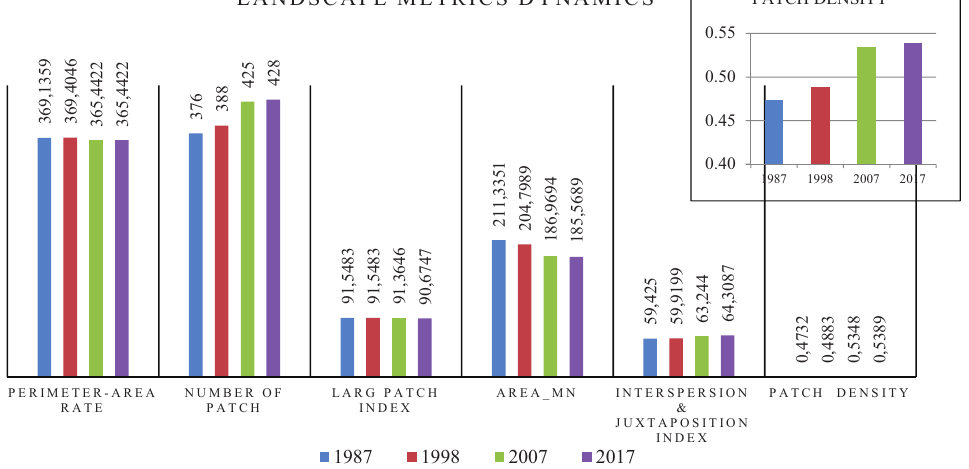
Figure 5. Quantification of composition and distribution metrics at a landscape level from 1987 to